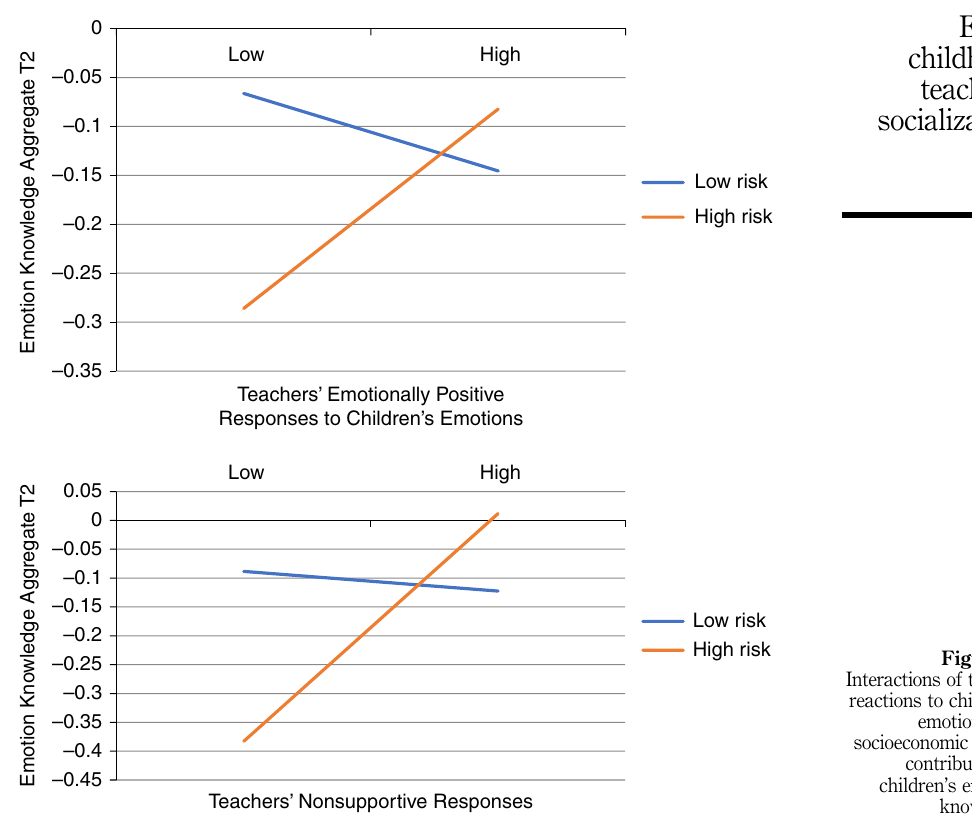
Figure 3. Interactions of teacher reactions to children ’ s emotions and socioeconomic risk in contributing